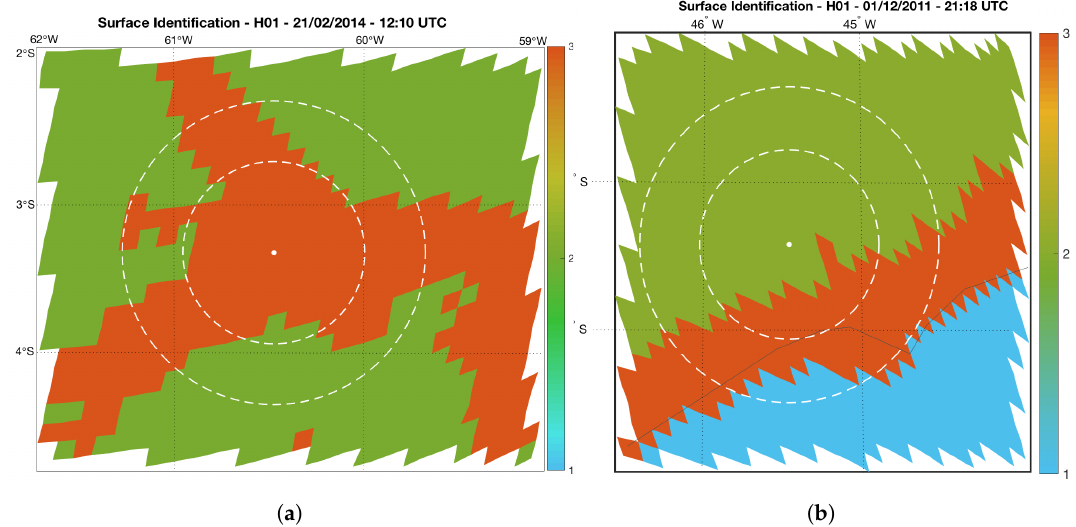
Figure 22. Surface Identification (1—Ocean, 2—Land, 3—Coast) for ( a ) Manaus and ( b ) Vale do